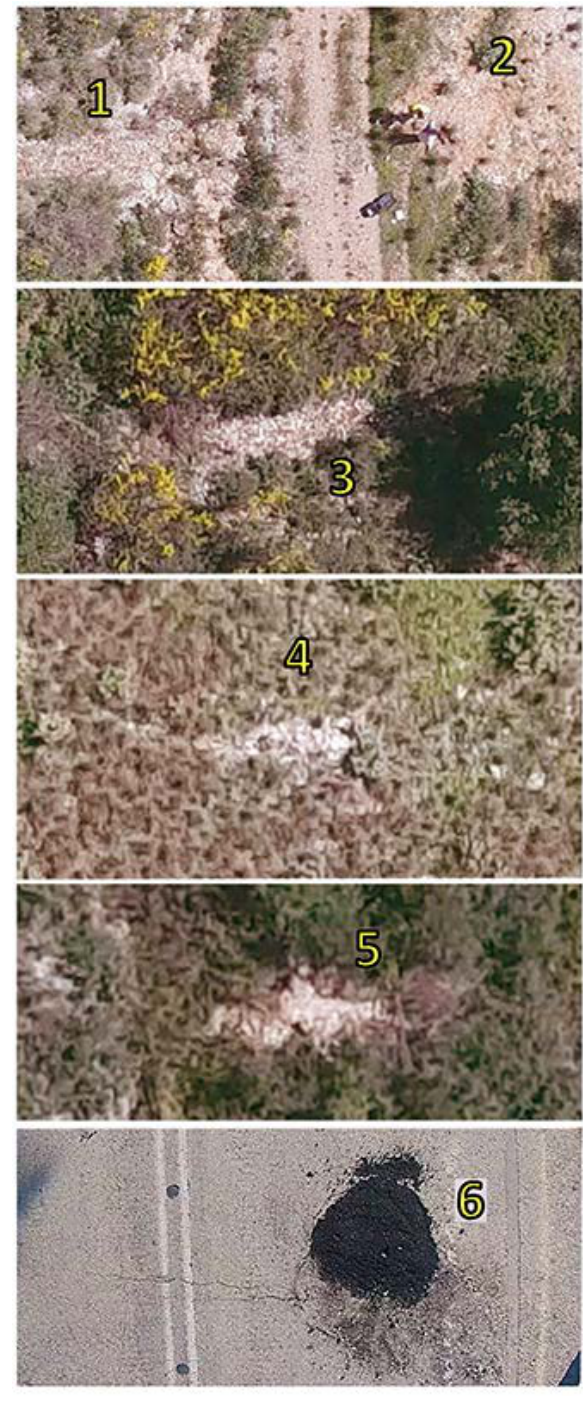
Figure 4. Top view orthophoto close-ups – Bouncing positions